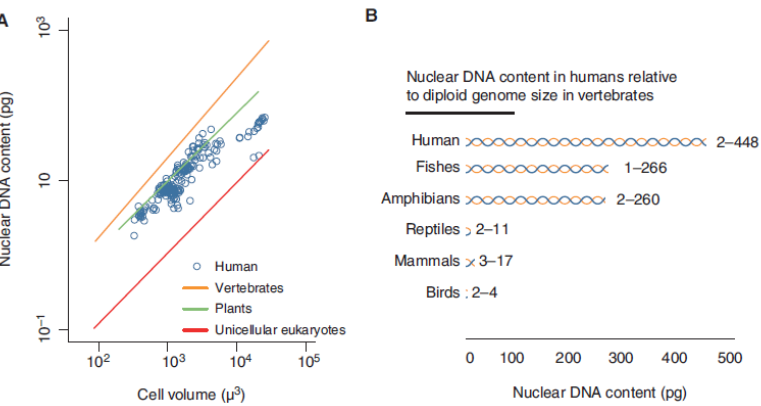
Figure 4. Relationship between nuclear DNA content and cell volume in humans. ( A ) Relationship between nuclear DNA content and cell size in diploid and polyploid human cells (blue) in comparison to previously reported relationships for diploid cells of vertebrates, unicellular eukaryotes, and angiosperms. Lines were fitted to previously reported relationships using ordinary least-squares regression. The range of the unicellular eukaryote cell and genome sizes is truncated to clearly show data for other groups. ( B ) Range of nuclear DNA content in individual human cells in comparison to ranges of diploid genome sizes within vertebrate groups. DNA content was rounded to the nearest whole number; plot and data were taken from [44] with copyright permission.